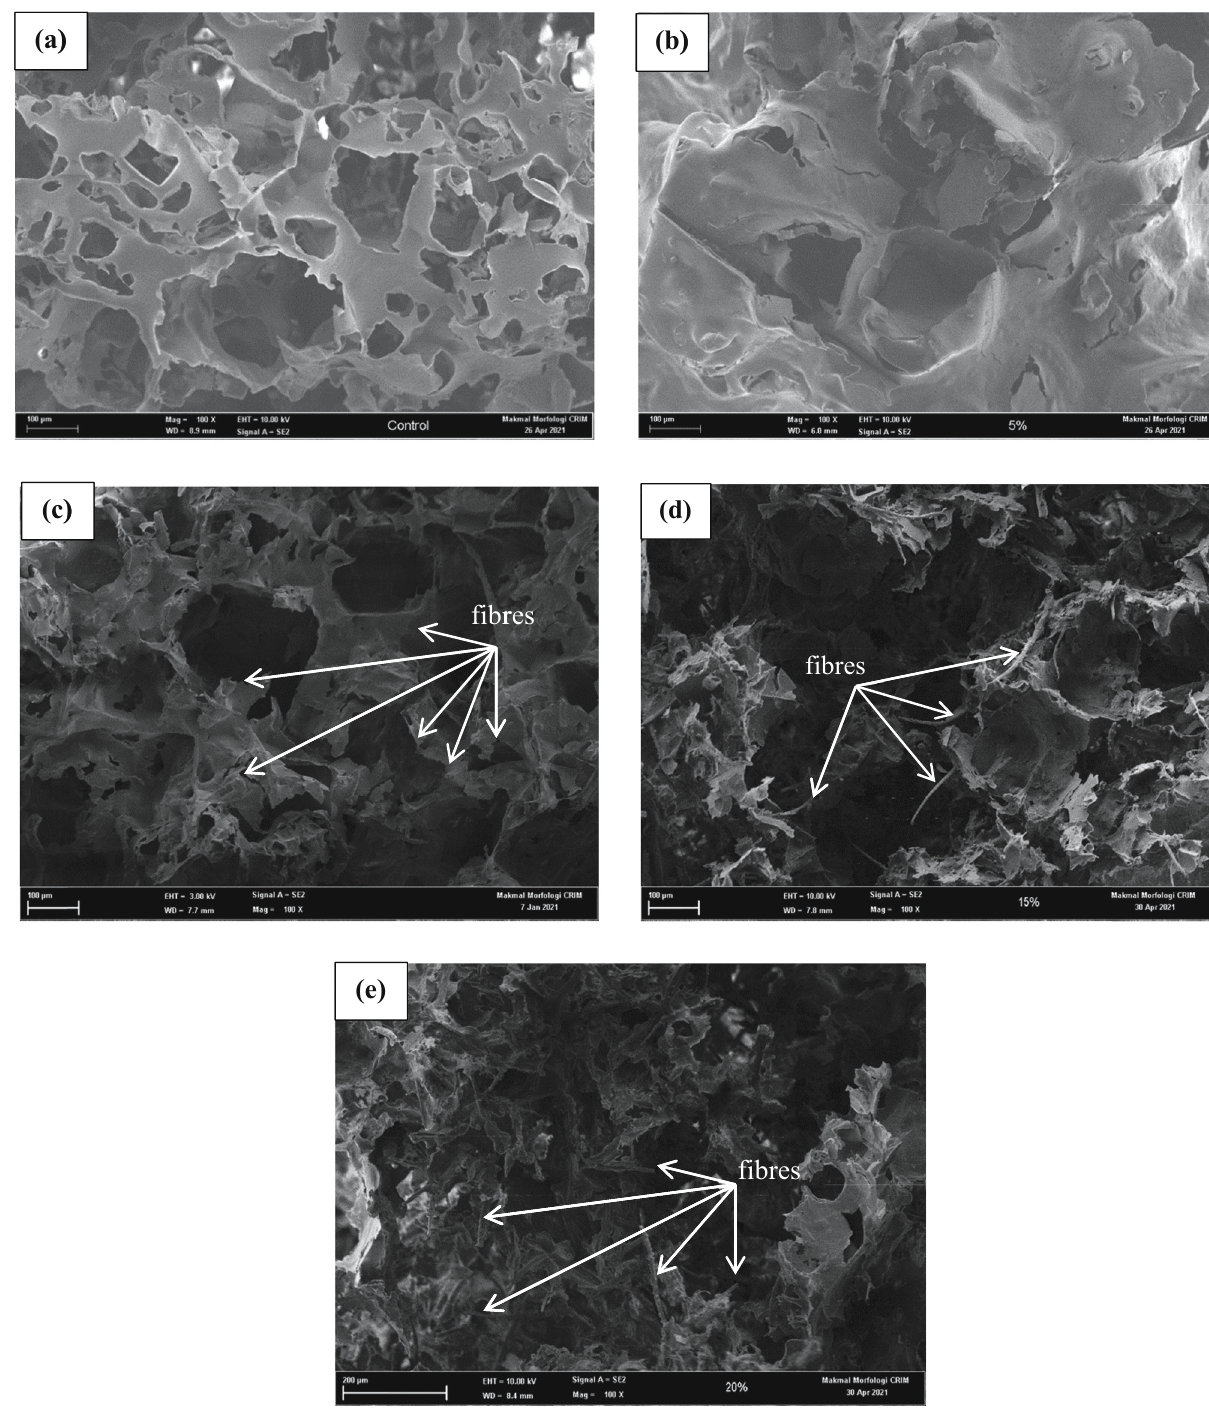
Figure 1: FESEM structure of ( a ) PLA CONTROL , ( b ) PLA/CNF - PP 5 , ( c ) PLA/CNF - PP 10 , ( d ) PLA/CNF - PP 15 , and ( e ) PLA/CNF - PP 20